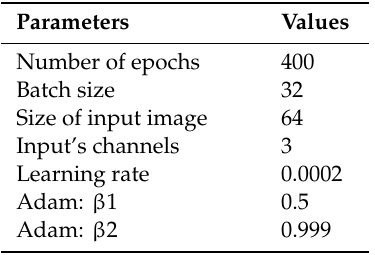
Table 4. Configuration parameters.